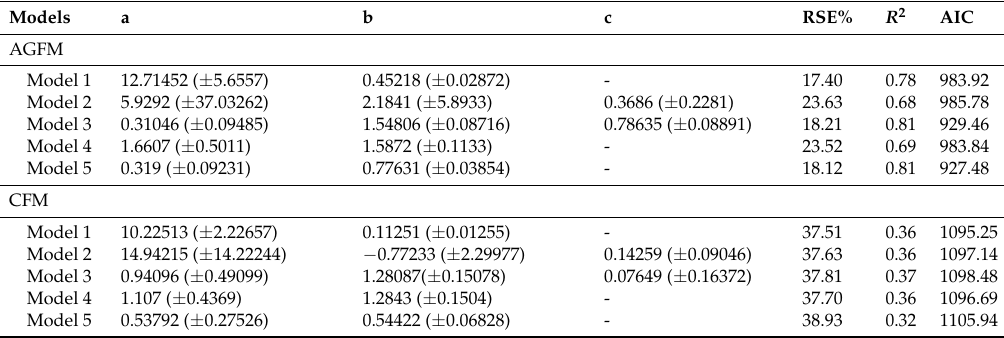
Table 3. Coefficients and statistics of five allometric models (Models 1–5) for estimating rosewood